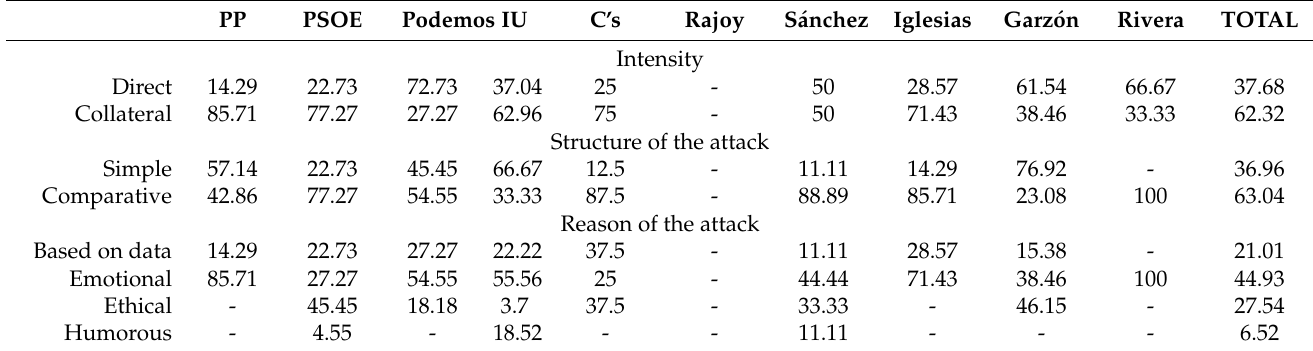
Table 4. How Political Actors Spread Criticism on Facebook